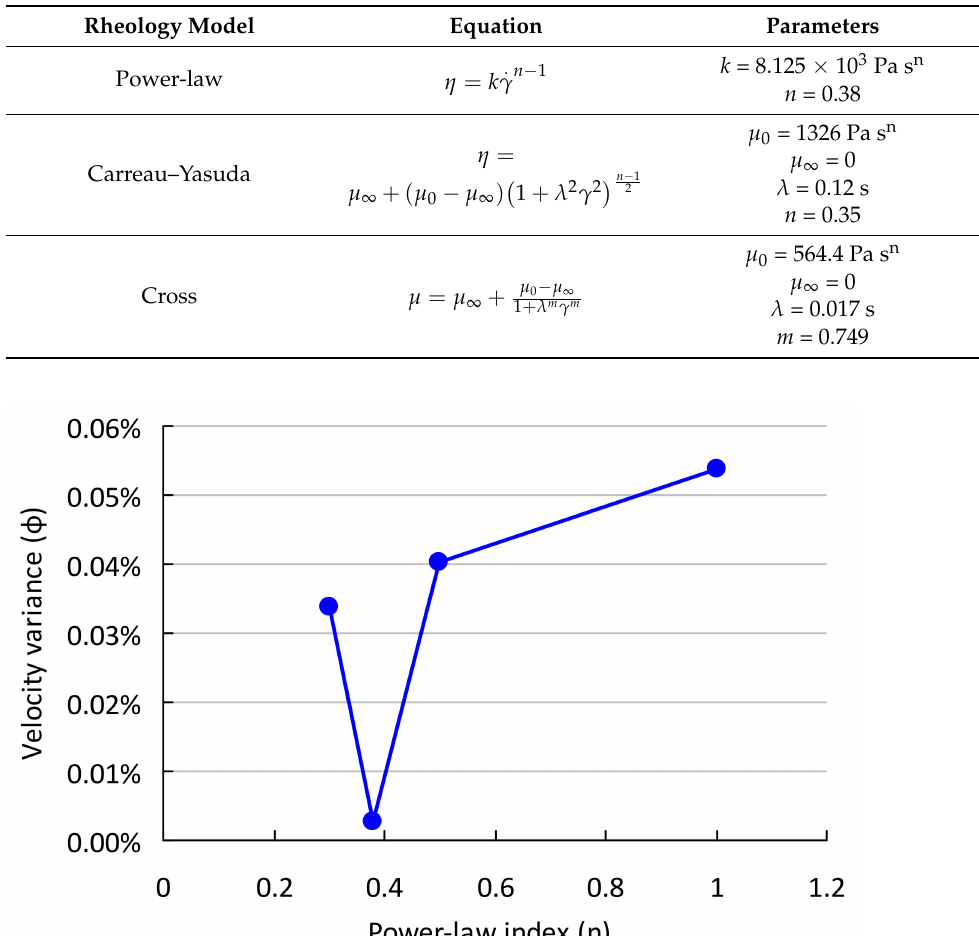
Table 1. Rheology models and corresponding parameters [20].